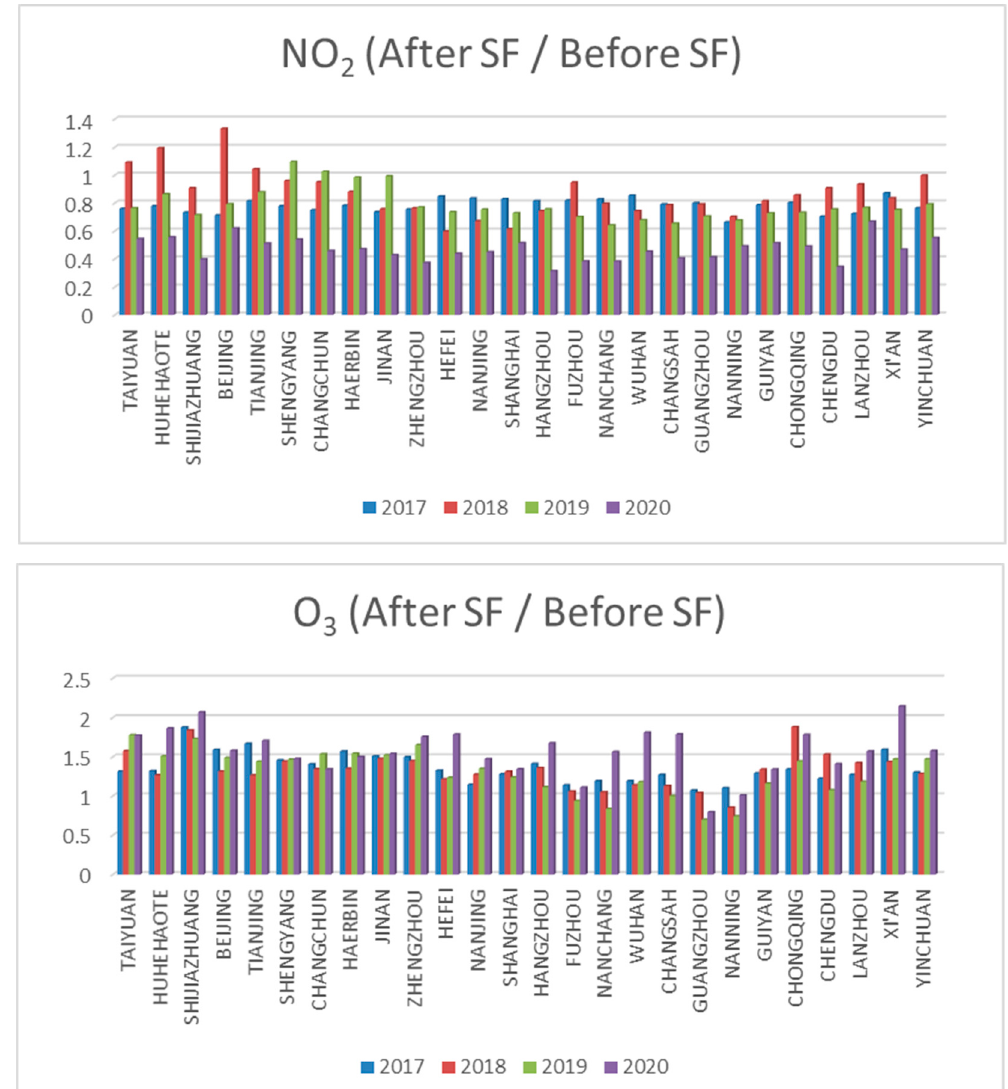
Figure 8. Ratio of the monthly averaged concentrations of NO 2 and O 3 after the Spring Festival to those before the Spring Festival, for each of 26 provincial capital cities for the years 2017–2020. The concentrations were averaged over a period of 30 days before and after Spring Festival. Note the different scales on the vertical axes.